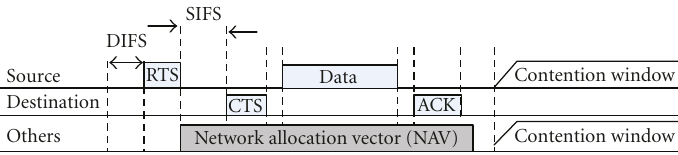
Figure 3: IEEE 802.11 MAC